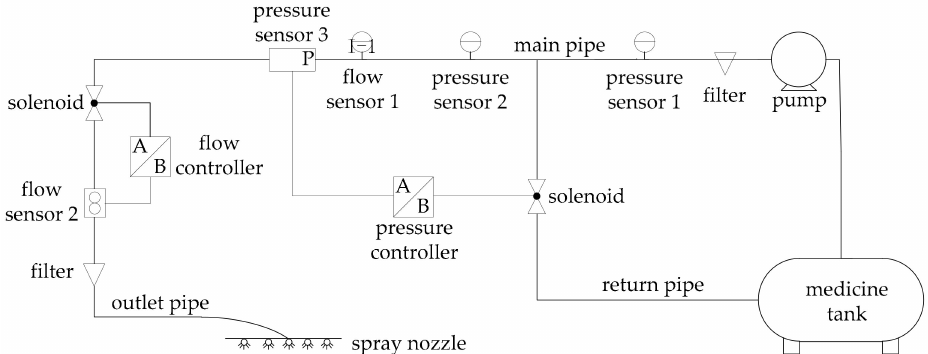
Figure 1. The spraying pipeline system with double closed-loop control (flow controller and pressure